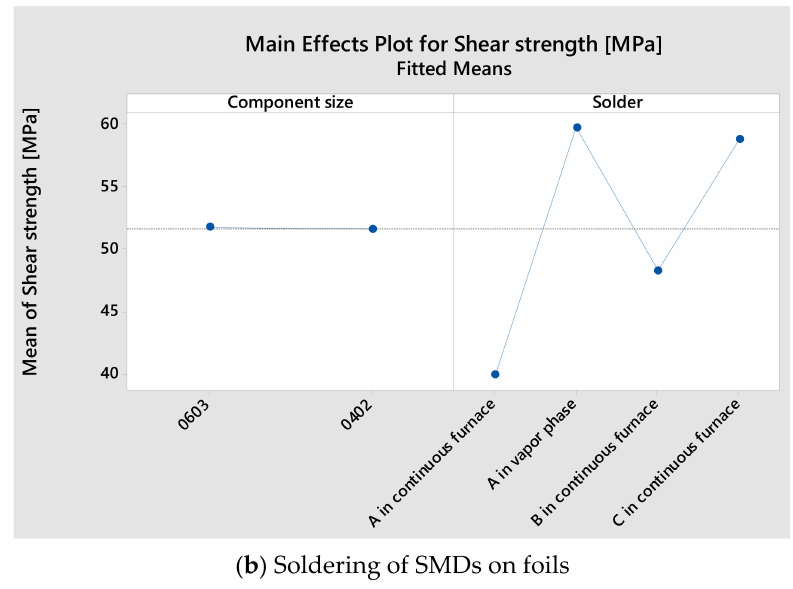
Figure 8. Main effect plots of the parameters influencing the shear strength.